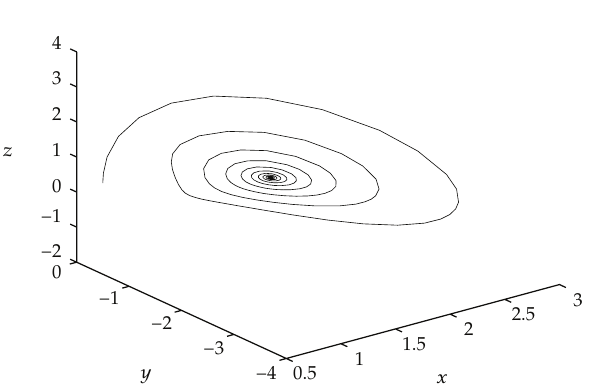
Figure 4: When K (cid:7) − 1 , τ (cid:7) 0 . 8, chaos vanishes, and S 1 becomes local stable. Here initial value is (cid:3) 0 . 5 , − 0 . 5 , 0 . 6 (cid:4) .